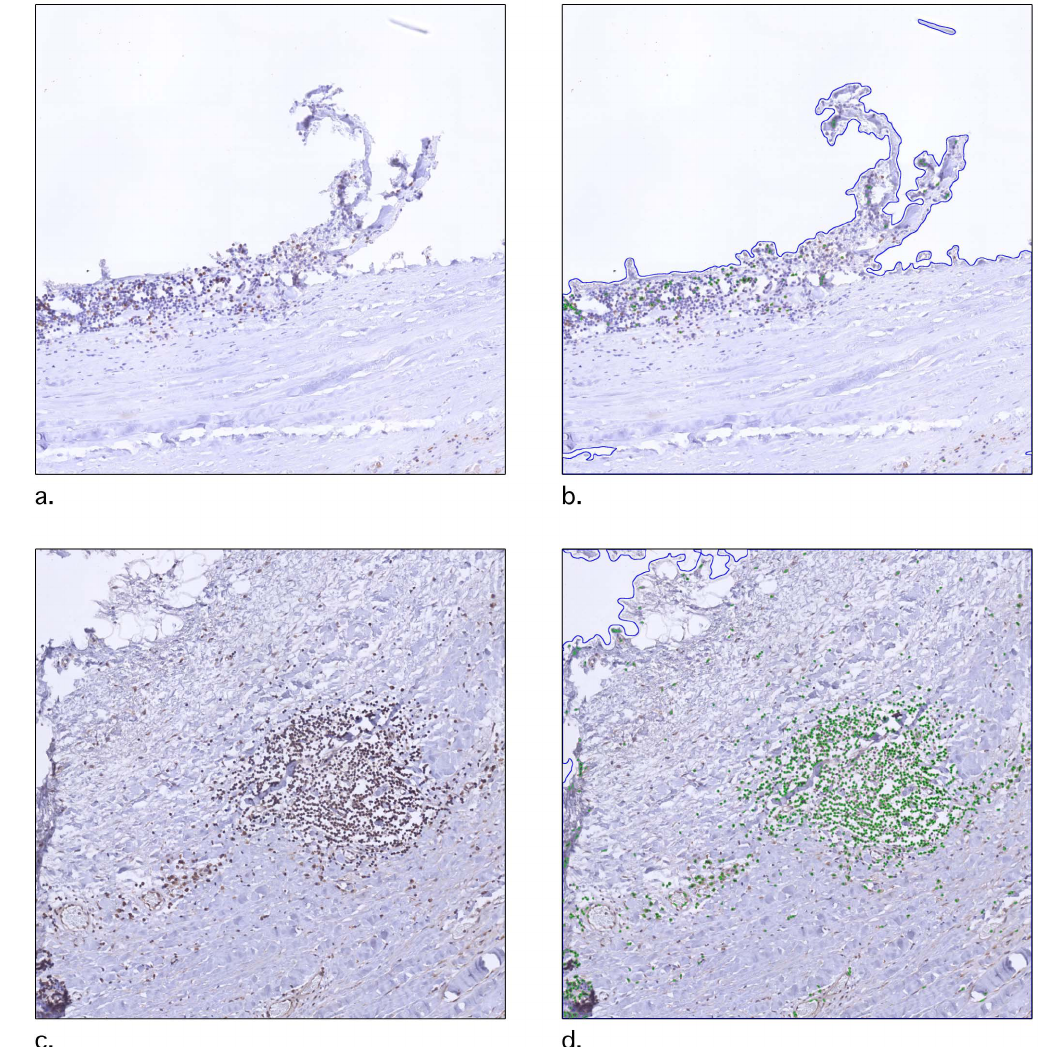
Figure 3. An example of object identification using the pipeline. a. and c. are original tiles, b. and d. are the same tiles with oulines of the identified objects. Blue lines outline the areas identified as tissue, green lines outline areas identified as DAB positive nuclei. These images are created using the ’SaveImages’ module in CellProfiler.